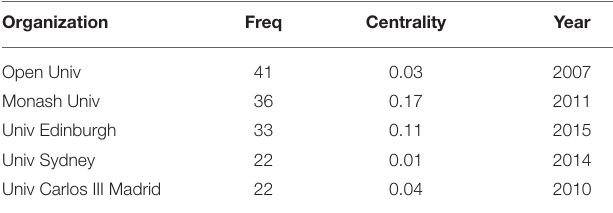
TABLE 2 | The top institutes with big data in education